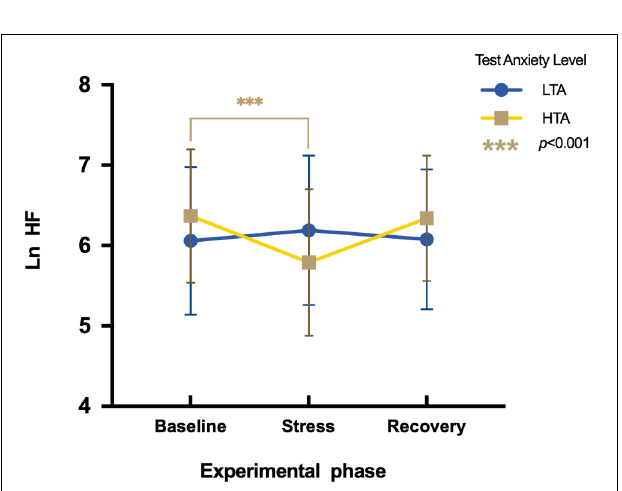
FIGURE 5 | Differences in Ln HF during three experimental phases of HTA and LTA individuals. ∗∗∗ represents a significant difference between the baseline and stress phase of HTA individuals with p -value <